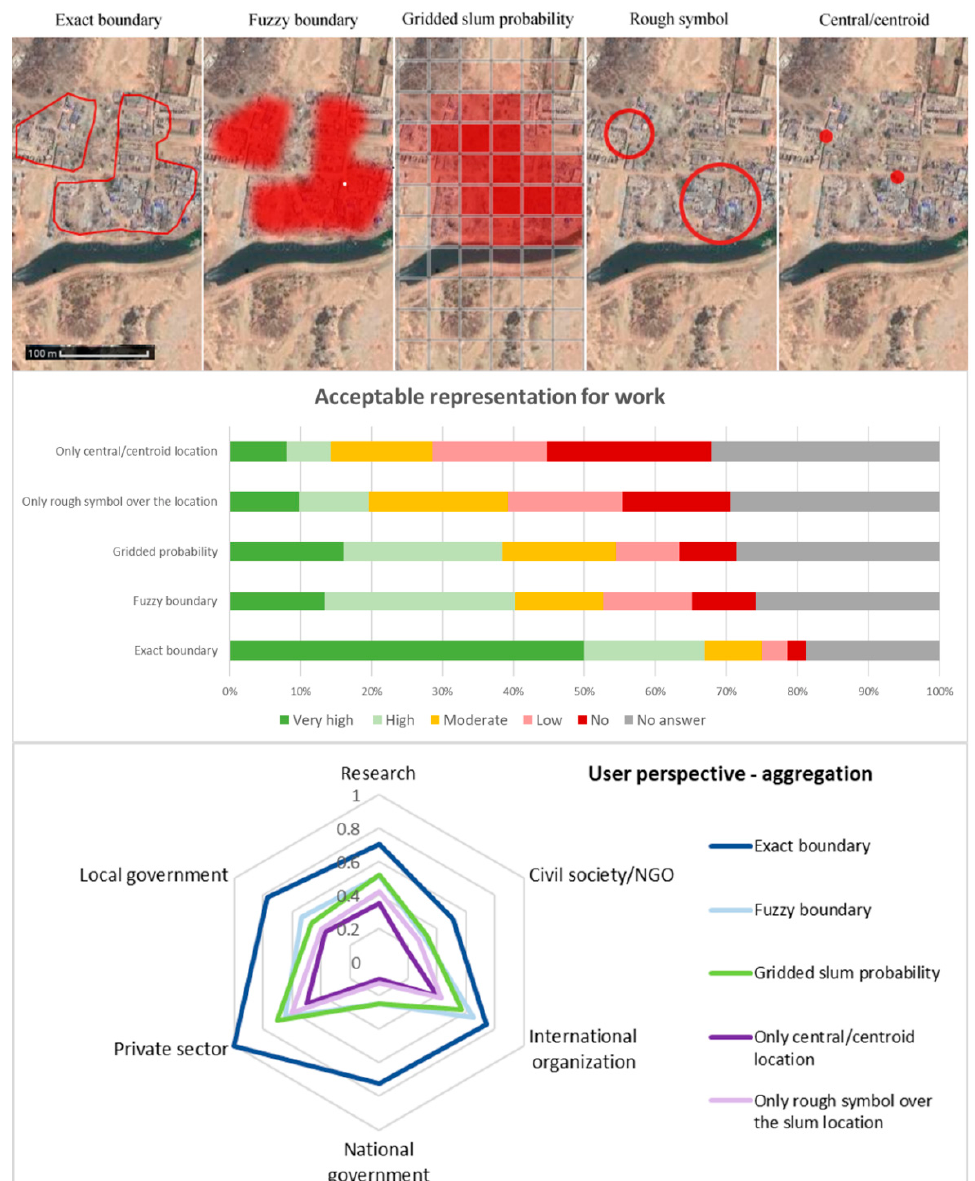
Figure 15. Suitable aggregation levels (upper), results of the online expert survey on the acceptable aggregation level of deprived area data (in %) (N = 112) (middle), user group preference scores of aggregation levels (1 = high preference and 0 = no preference) (lower).